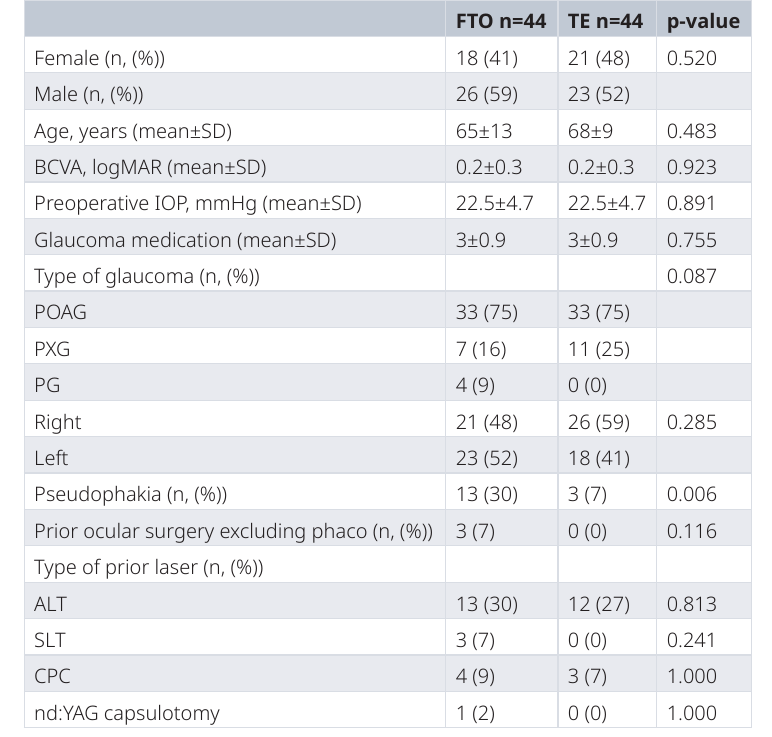
Table 1. Demographic data of both groups after